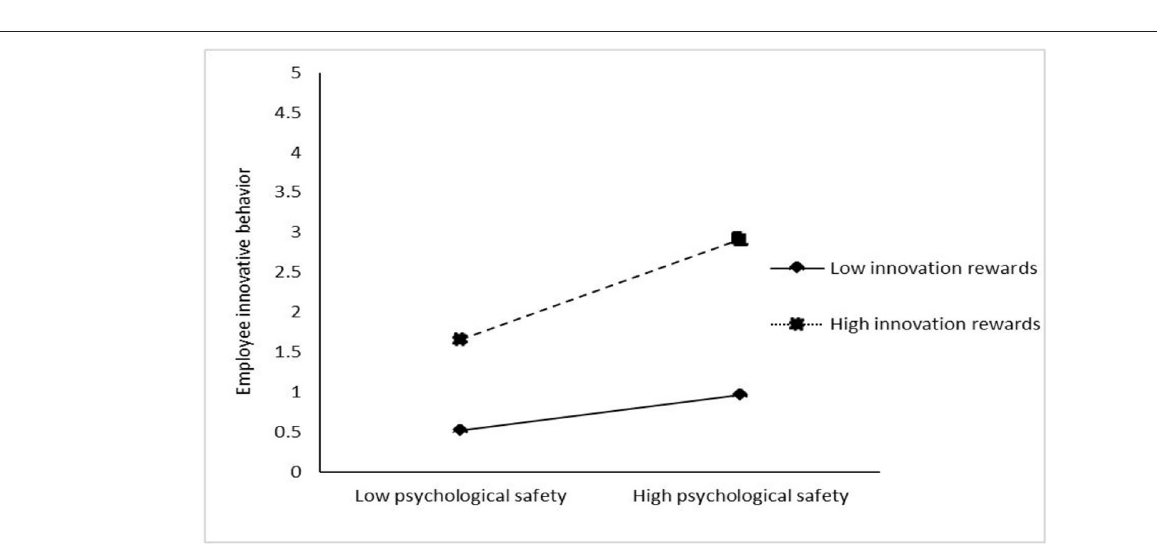
FIGURE 4 | Moderating effect of innovation rewards on the relationship of psychological safety and employee innovative